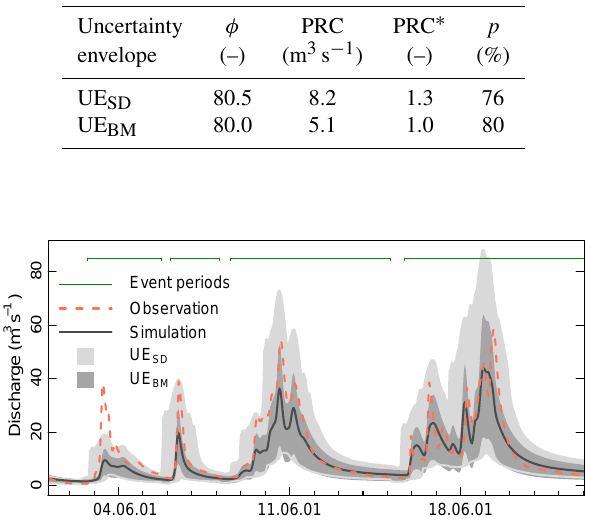
Figure 7. Time series detail showing the resulting one- and two- dimensional uncertainty envelopes around the historic stream- flow simulation. The envelopes were derived upon Series Dis- tance (UE SD ) and the benchmark approach (UE BM ), respectively, using error dressing. Please note that the coverage of the SD and BM envelope may differ for different subsets of the time series, like in this detail. For the entire time series, however, the coverage of BM and SD are identical.